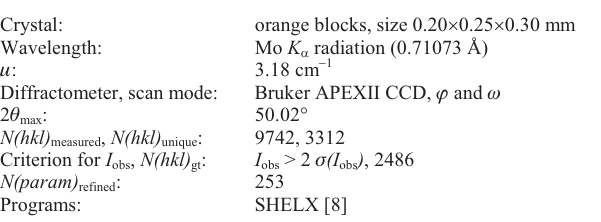
Table 1. Data collection and handling.